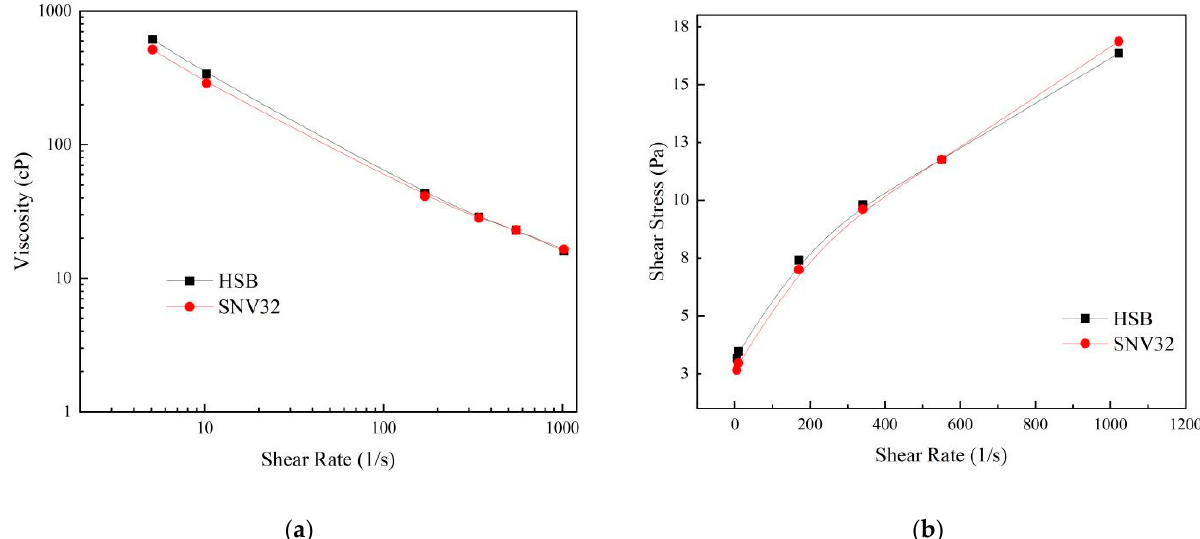
Figure 9. Comparison of SNV and HSB. ( a ) Shear rate and viscosity curves, ( b ) shear rate and shear strength curves.